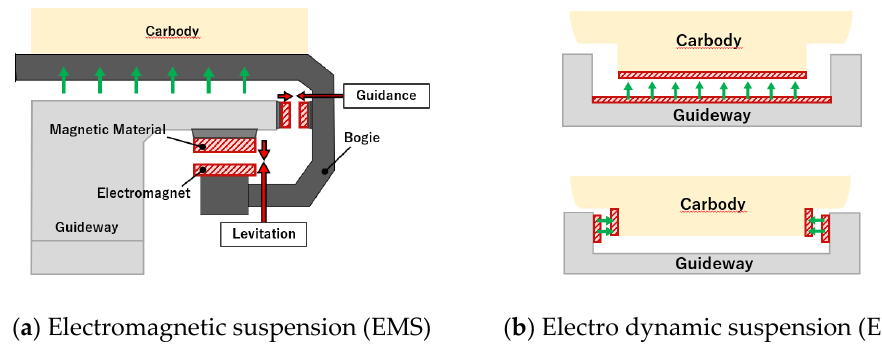
Figure 1. Principle of electromagnetic suspension and electro dynamic suspension.